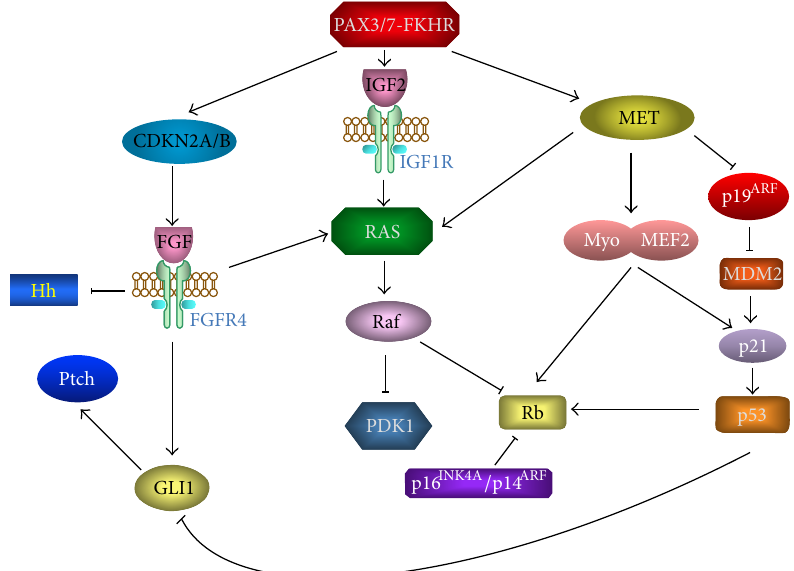
Figure 3: Genetic analyses of RMS have pinpointed several common alterations, including inactivation of a master regulator of p53 and Rb pathways, CDKN2A/B, and activation of FGFR4, RAS, and Hedgehog (Hh) signaling. The modifications of these pathways influence oncogenesis and metastatic